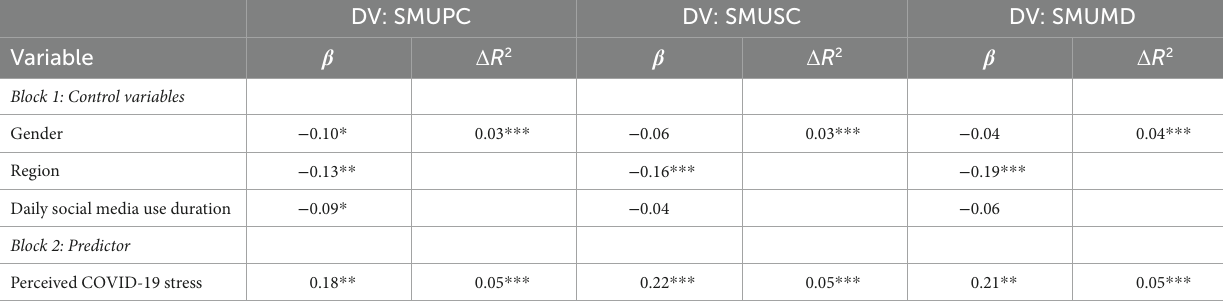
TABLE 3 Coefficients of regression analysis predicting social media coping